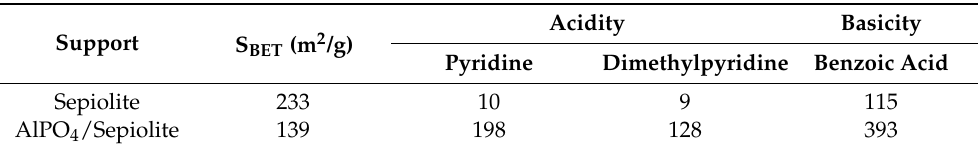
Table 1. Surface area (S BET ) and acid-base properties ( µ mol py · g − 1 ), obtained by titration with pyridine (py, pKa = 5.3), 2,6-dimethylpyridine (dmpy, pKa = 7) and benzoic acid (ba, pKa = 4.19), of Sepiolite and AlPO 4